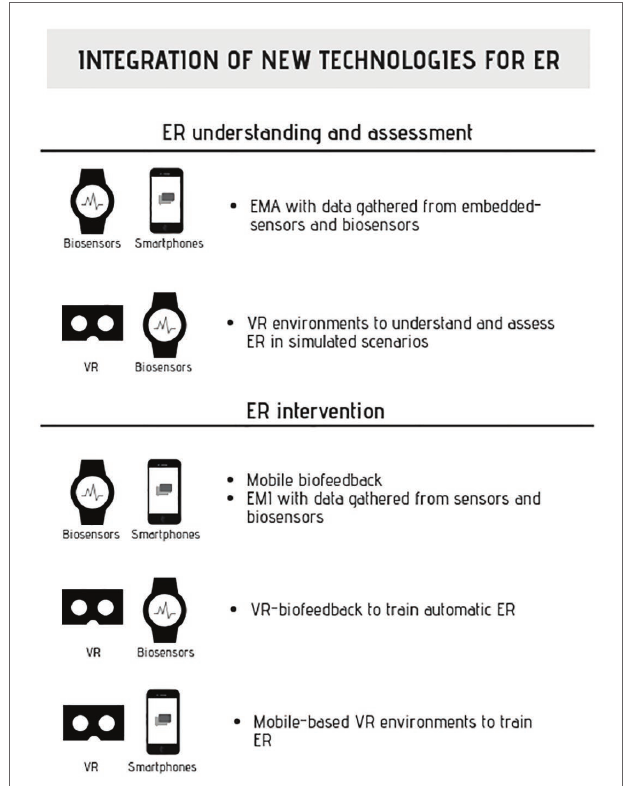
FIGURE 2 | Examples of the complementary and integrative role f new technologies for the understanding assessment and intervention of ER. ER, emotion regulation; EMA, ecological momentary assessment; VR, virtual reality; EMI, ecological momentary